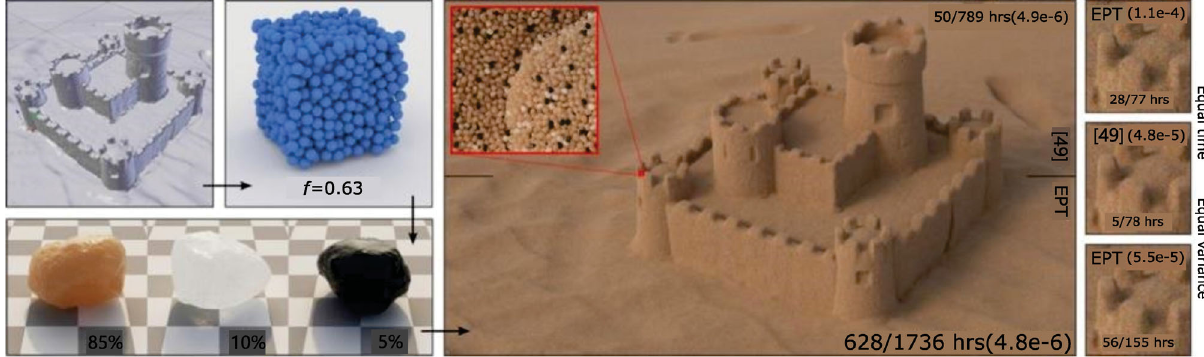
Fig. 21 Participating media in discrete space. Reproduced with permission from Ref. [68], c (cid:2) ACM